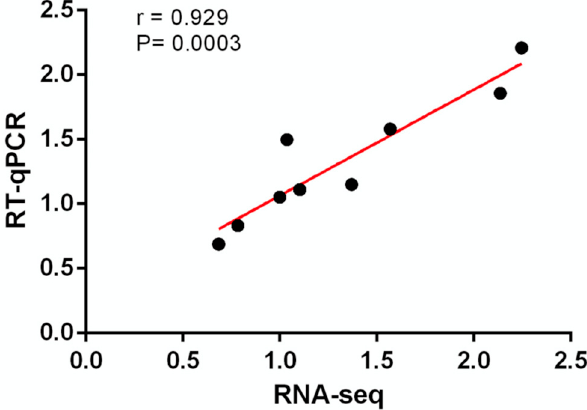
Figure 9. Pearson correlation analysis of quantitative real-time PCR qRT-PCR results and transcriptome sequencing data.